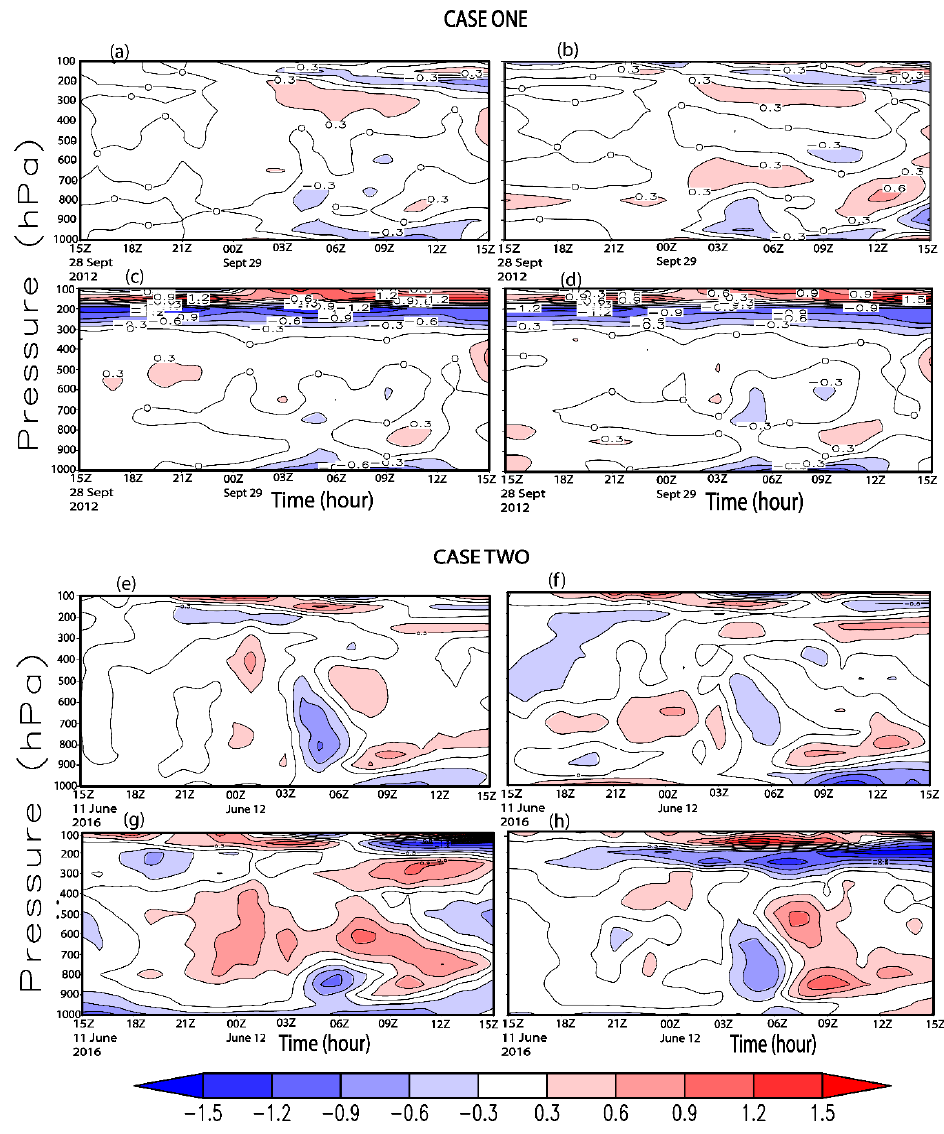
Figure 6. Pressure-time cross sections of the differences in air temperature (K) CASE ONE ( a )